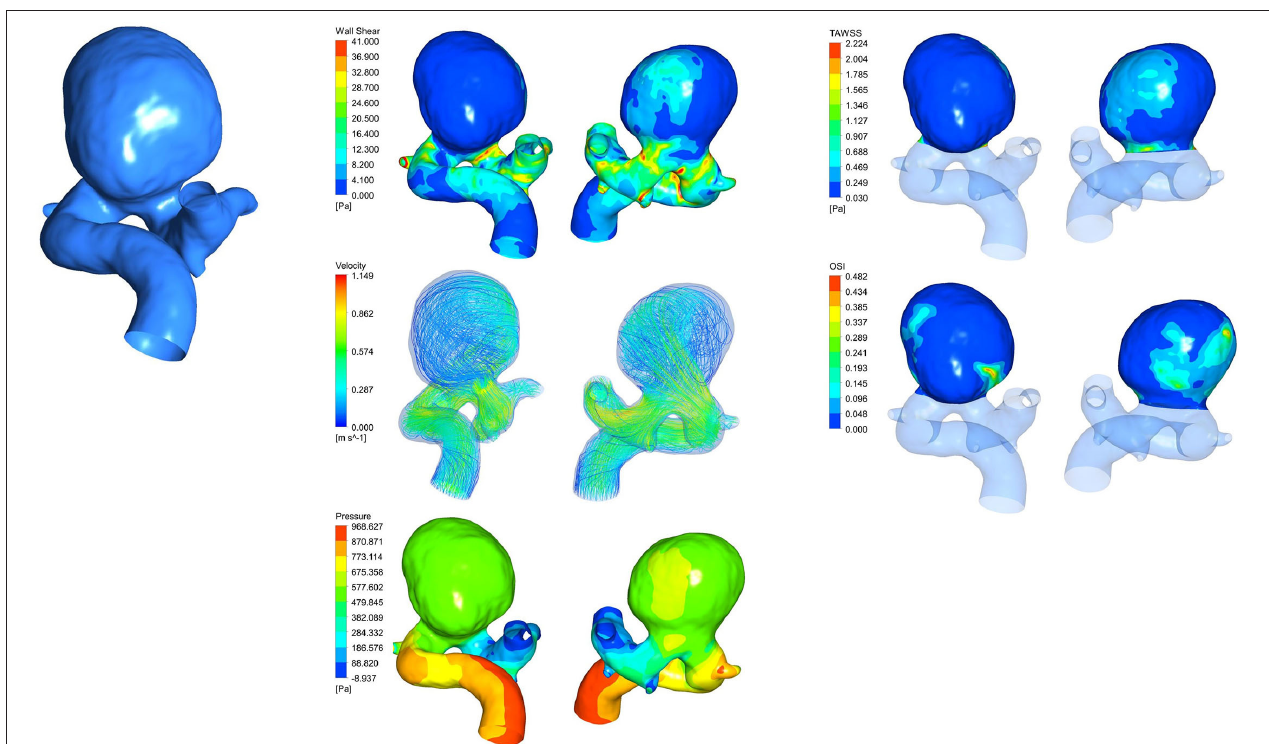
FIGURE 3 | Hemodynamic clouds of WSS, TAWSS, velocity, OSI, and